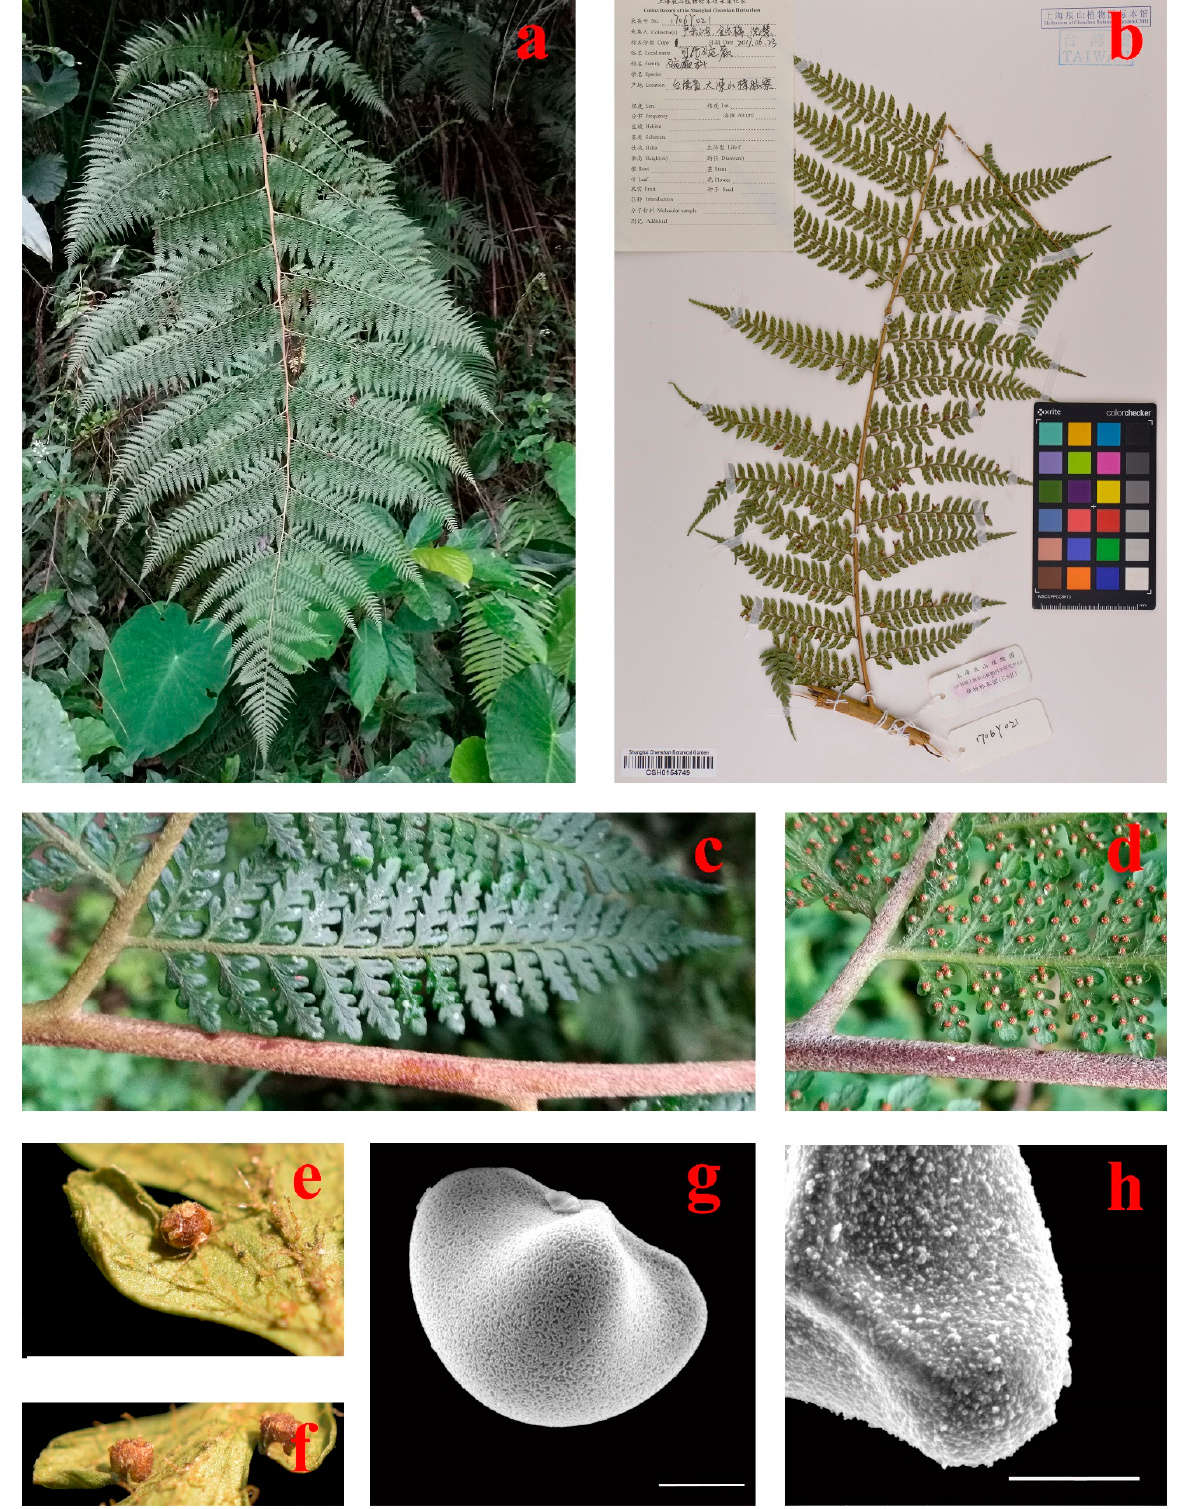
Figure 1. Morphological characters in Microlepia smithii . ( a ): M. smithii in the forest; ( b ): Herbarium specimen of M. smithii ; ( c ): Ultimate-pinnule in live specimen; ( d ): Position and shape of sori in life specimen; ( e , f ): Indusia in dried herbarium specimen; ( g ): SEM of equatorial view of spore showing inner perispore reticulation with small areolae; ( h ): SEM of outer perispore showing granular. Scale bar in ( g , h ) = 10 µm.